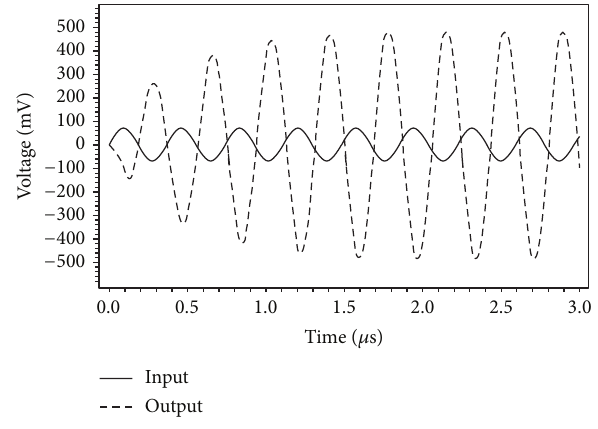
Figure 12: Time response of BP response.